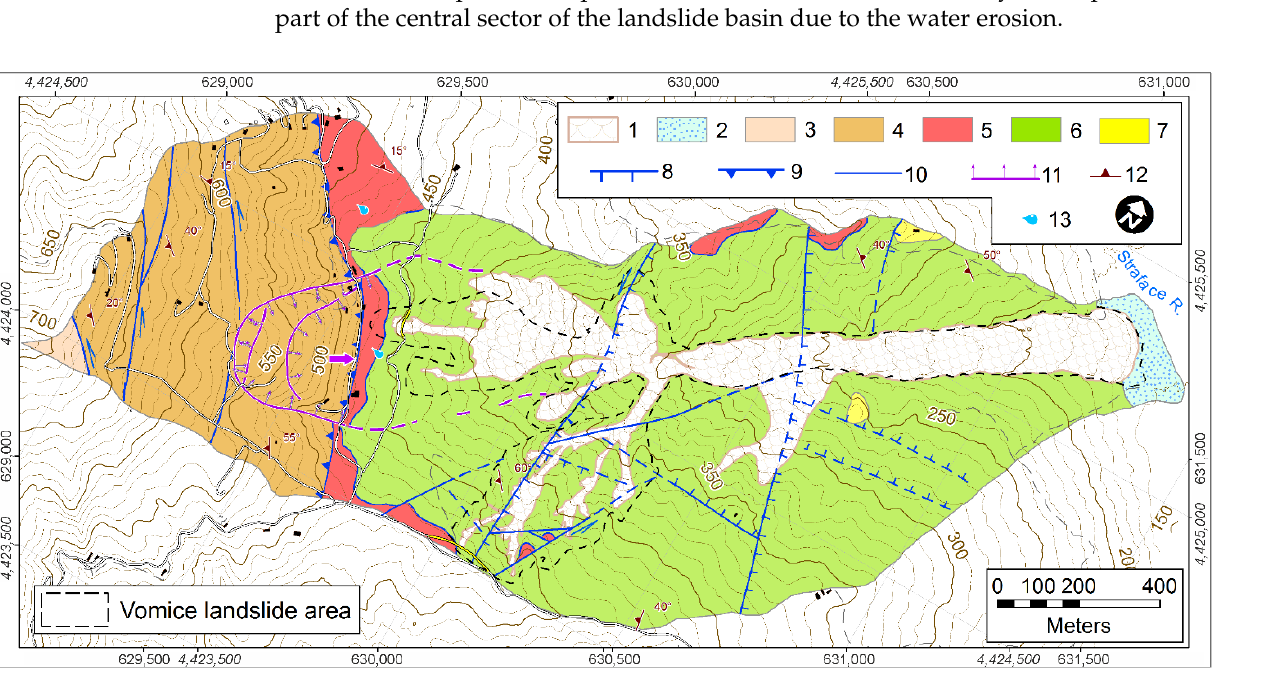
Figure 2. Geostructural map of the study catchment with localization of mesostructural stations and synthesis of mesostructural data and a geological cross section of the slope. Legend: (1) Holocene landslide debris; (2) Holocene alluvial deposits; (3) Albidona Formation (Burdigalian); (4) Saraceno Formation (Upper Oligocene–Aquitanian); (5) Numidian Flysch (Lower Miocene); (6) lower varicolored clays (Cretaceous); (7) olistoliths of the Sant’Arcangelo Formation (Upper Cretaceous–Middle Eocene); (8) normal fault; (9) thrust; (10) tectonic contact; (11) deep-seated rock-slide; (12) attitude of strata; and (13) spring (from Conforti et al. [60], modified).